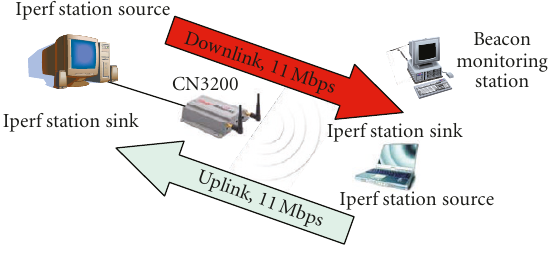
Figure 18: Measurement